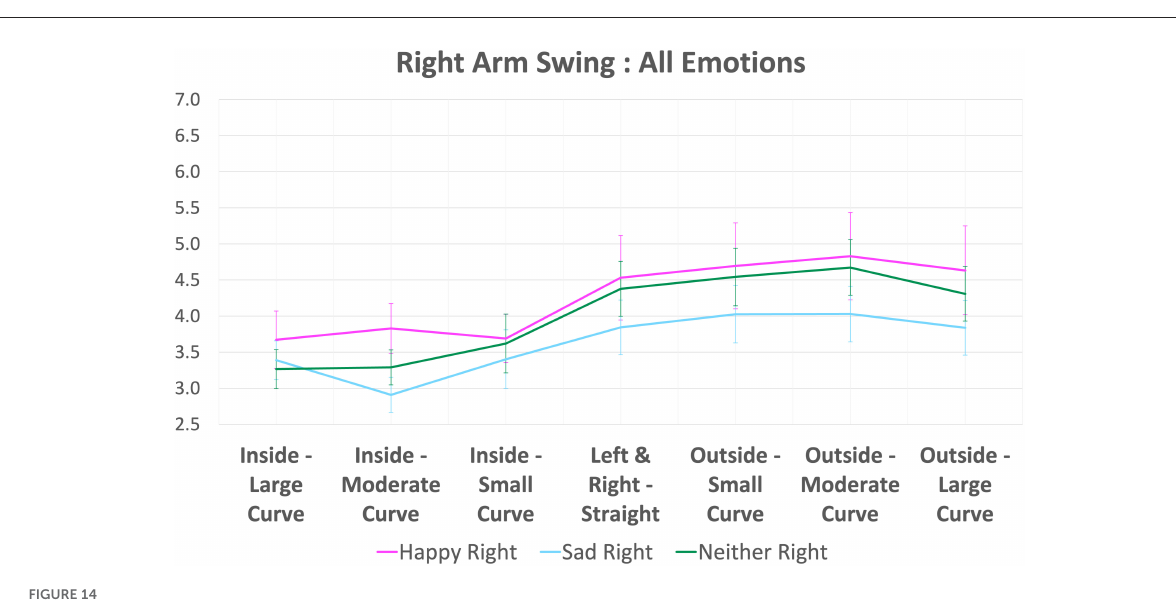
the right arm swings’ slopes is smaller than that in the left arm swings’ slope ( β = 0.0206 and β = 0.0142, respectively). Hence, the right arm swing magnitudes under happy and sad emotions are also different from each other, but not so much different as they are in the left arm. Under the neither emotion, the slope of the left arm swings is much different from the slopes of happy and sad emotions ( β = 0.0017). However, the slope of the right arm swings is quite similar to the slope of happy